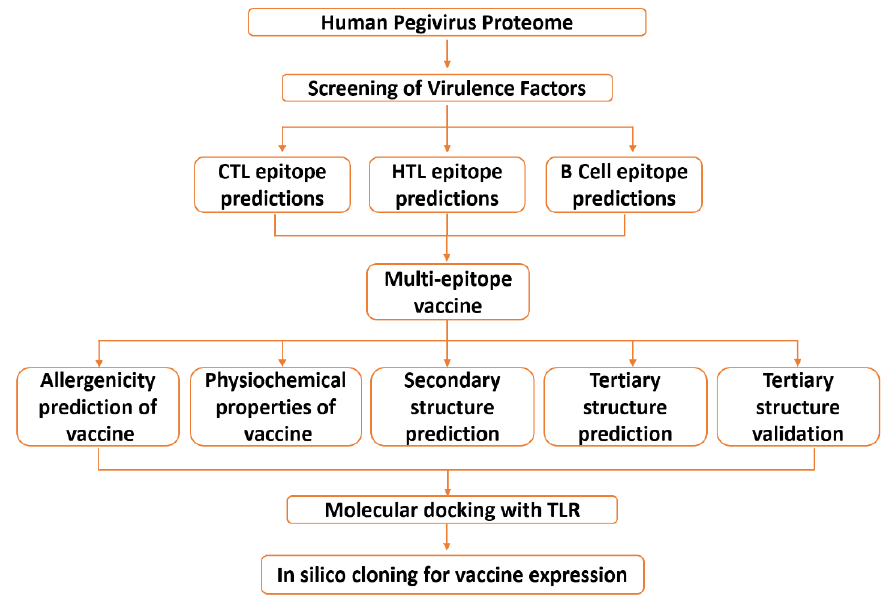
Figure 1. The overall workflow: from proteome retrieval to multi-epitope vaccine design and its validation through in silico cloning and immune simulation. validation through in silico cloning and immune